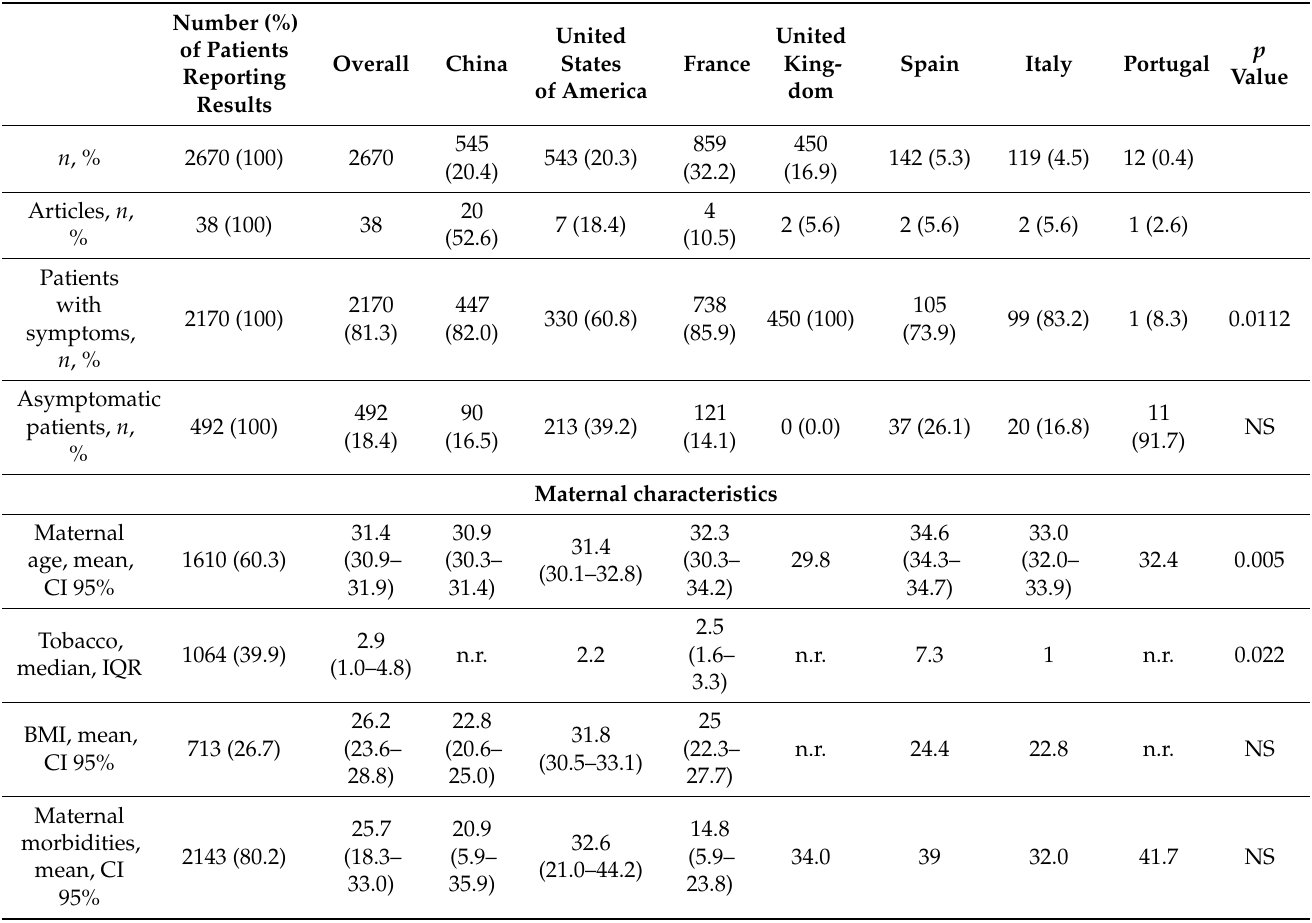
Table 1. Description of the main variables in the overall series and comparison of the results by countries. Number (%) of